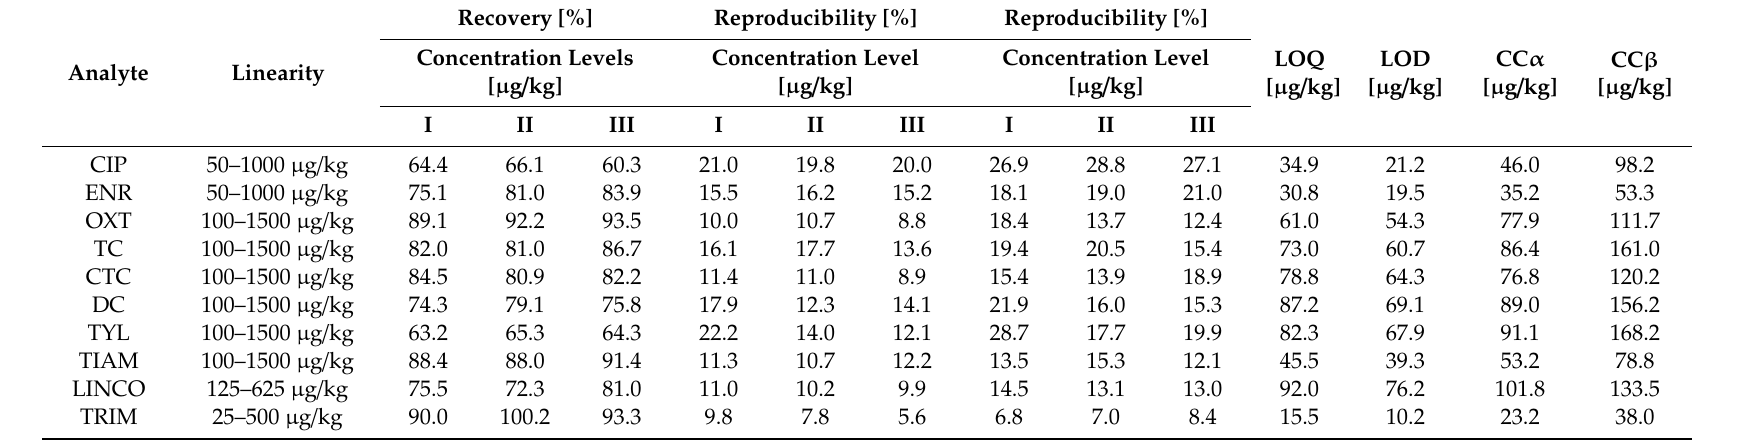
Table 1. Validation parameters of the optimized